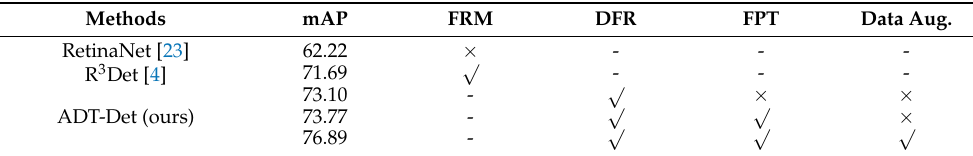
Table 1. Ablation study of DFR, FPT, and data augmentation.